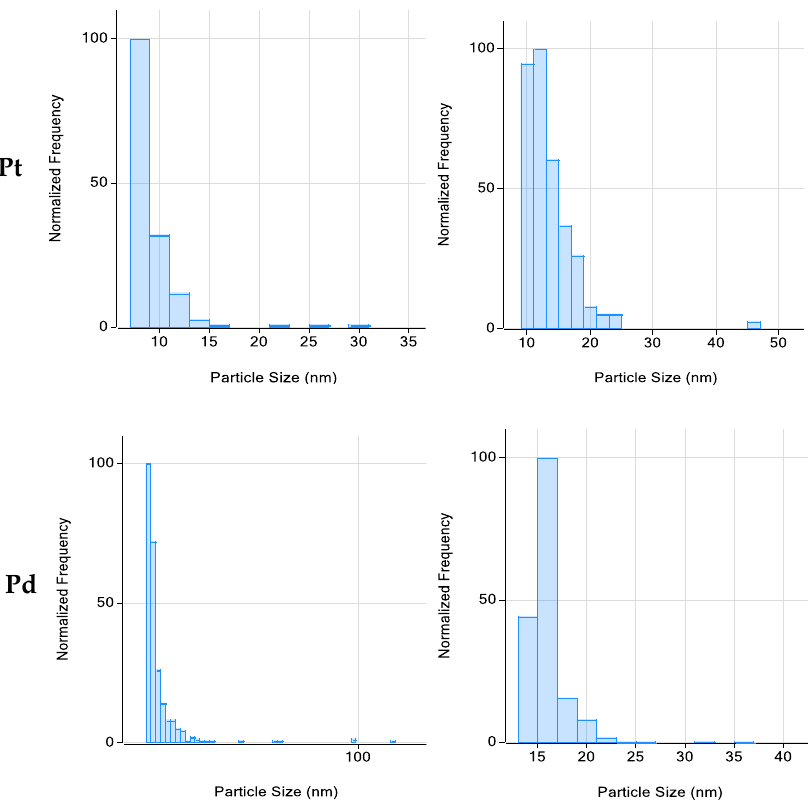
Figure 2. Typical examples of particle size distribution of nanoparticulate Pt and Pd as obtained by spICP-MS.